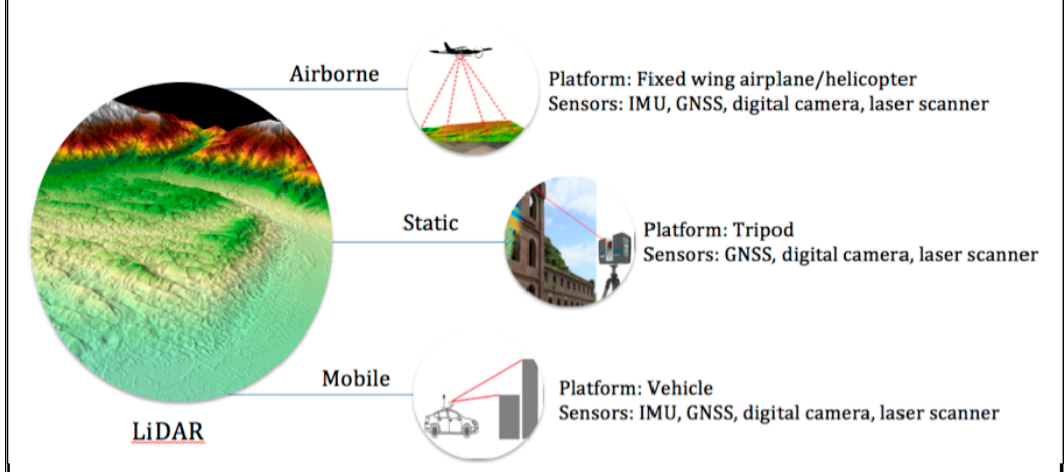
Figure 1. Light detection and ranging (LiDAR) survey data acquisition.